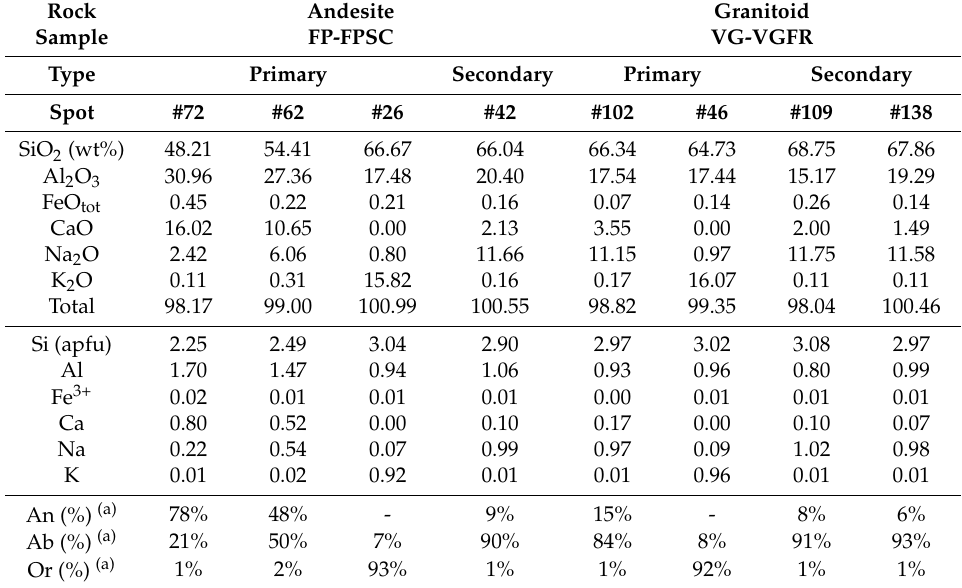
Table 1. Representative Electron Microprobe analyses and chemical formulae of feldspar from Isadalu magmatic complex.